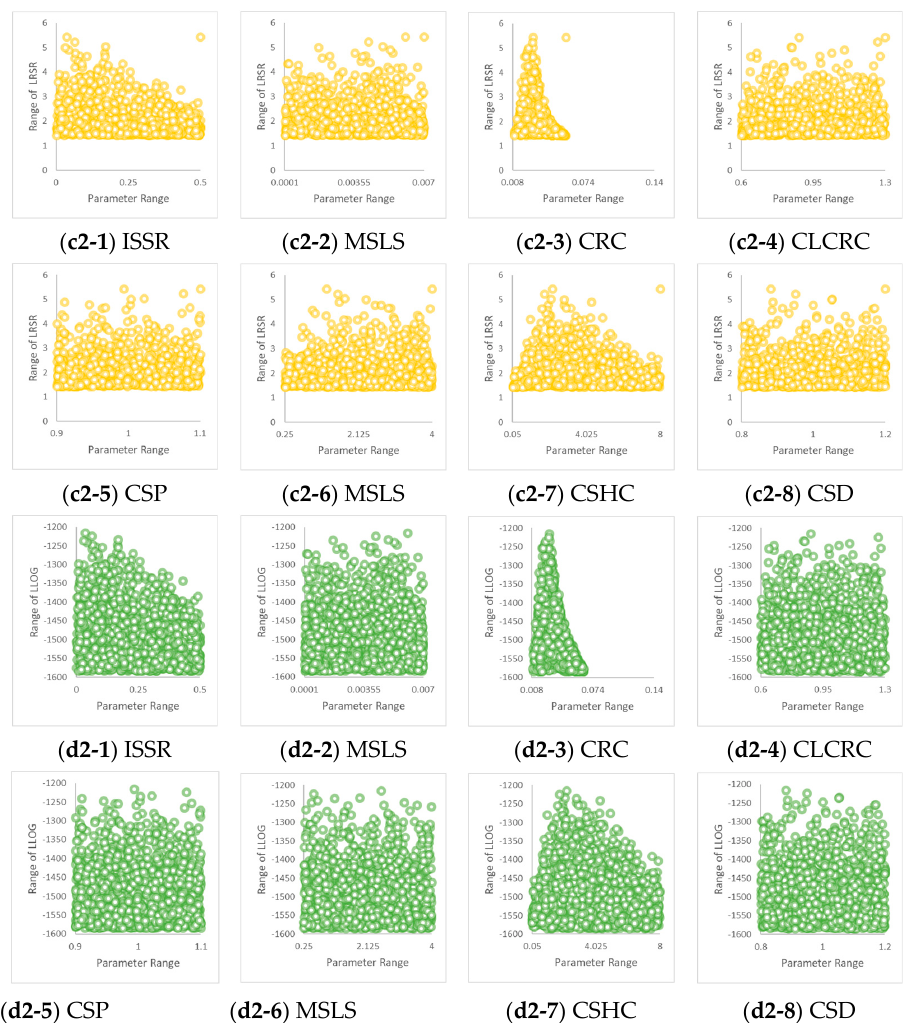
Figure 6. Event 2 dotty plot of behavioral parameters based on formal and informal likelihood. ( a2- 1 − a2-8 ) LNSE results; ( b2-1 − b2-8 ) LPBIAS results; ( c2-1 − c2-8 ) LRSR results; ( d2-1 − d2-8 ) LLOG re-